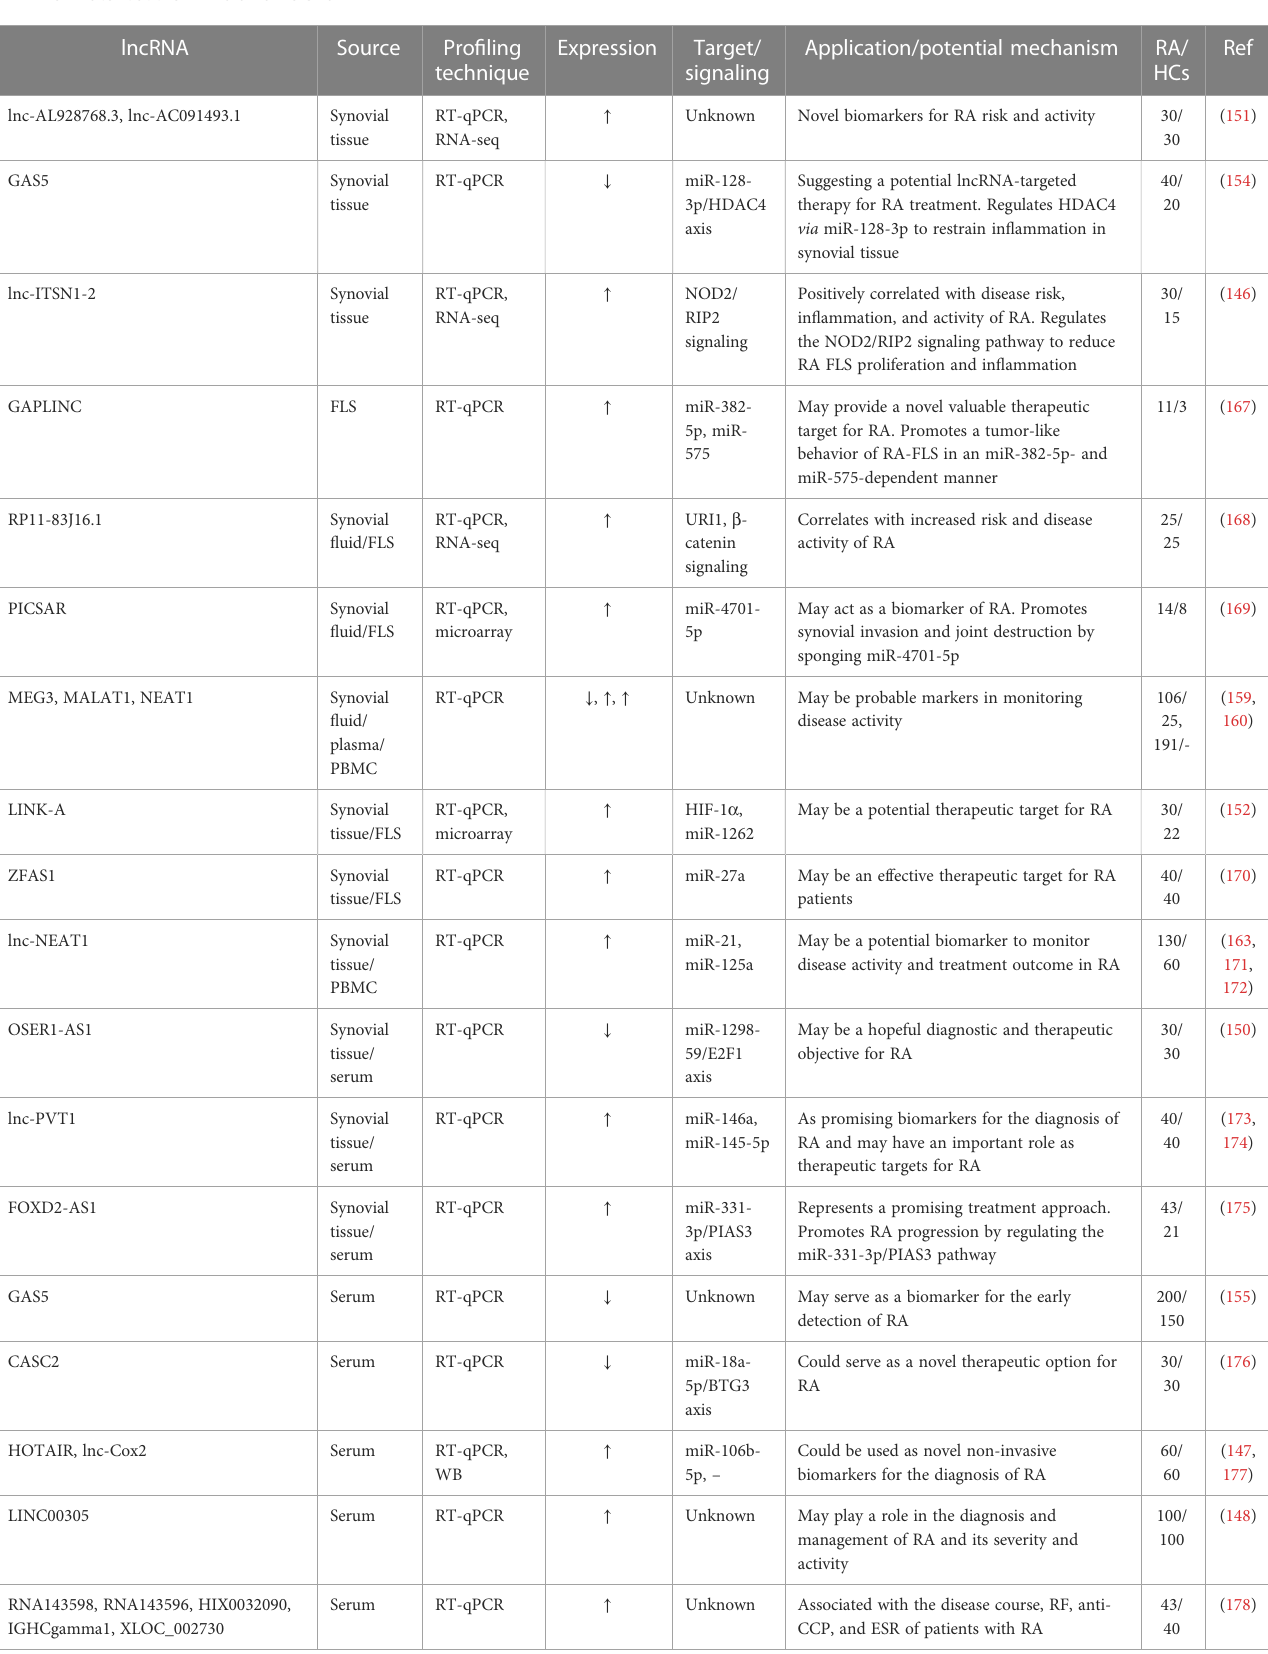
TABLE 3 Potential lncRNA biomarkers for